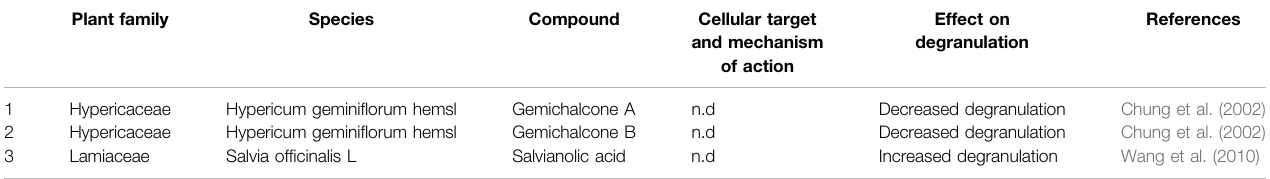
TABLE 5 | List of selected compounds isolated from plant material with documented impact on degranulation of neutrophils. Plant